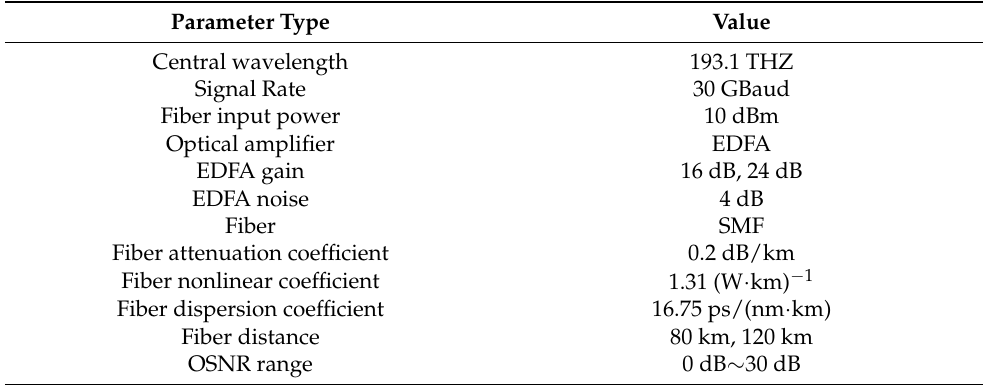
Figure 3. Simulation system setup. Table 1. Cohert optical fiber communication system